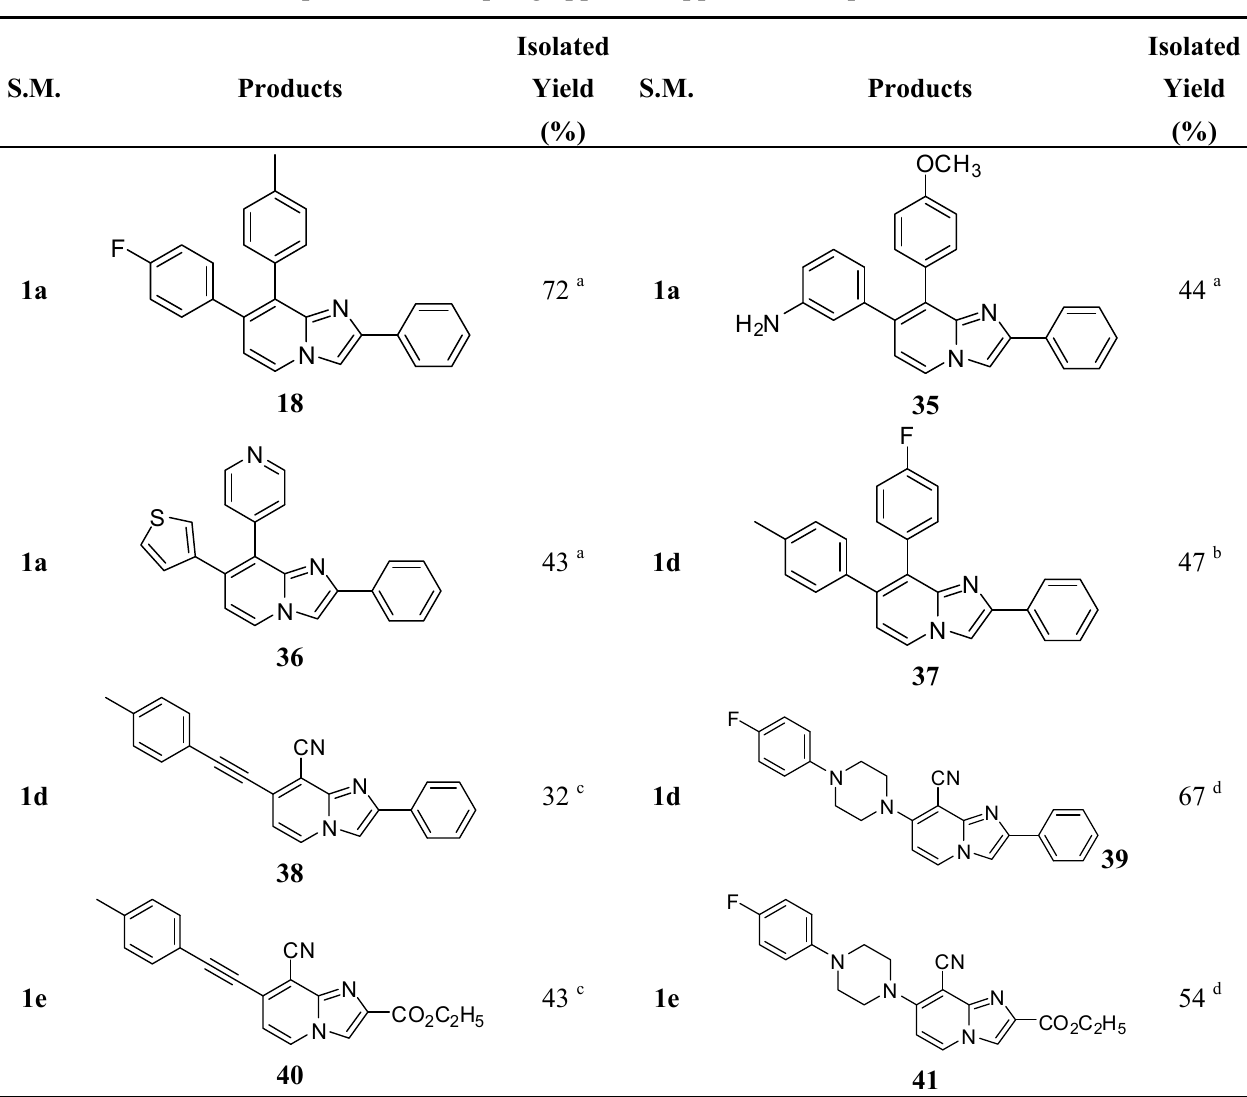
Table 4. One pot double-coupling approach applied to compounds 1a , 1d and 1e